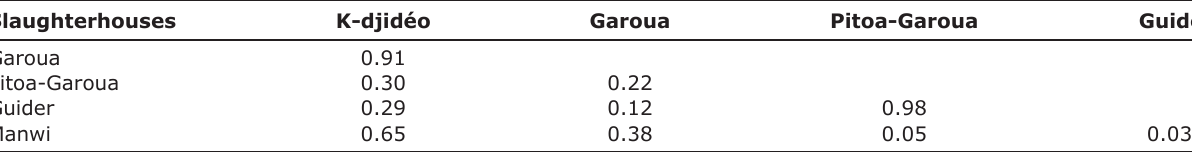
Table-2: Comparison of loads of Staphylococcu s with positive coagulase among the slaughterhouses. Slaughterhouses